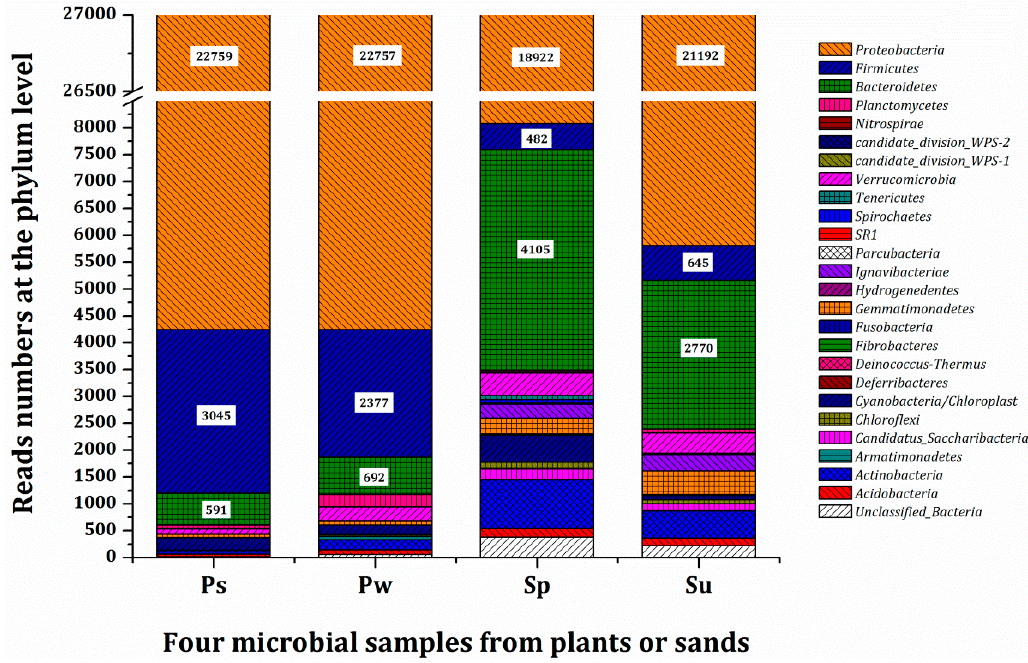
Figure 3. Microbial communities in the samples from plants or sands at the phylum level. Some phyla (read numbers < 10) are grouped into “others”. Ps: sample from rhizoplane in Tcw; Pw: sample from rhizoplane in Tcp; Sp: sample from sand in Tcw; Su: sample from sand in Tcs. The microbial samples from the plants rhizoplane and the substrate were obtained at the end of the 6th batch.